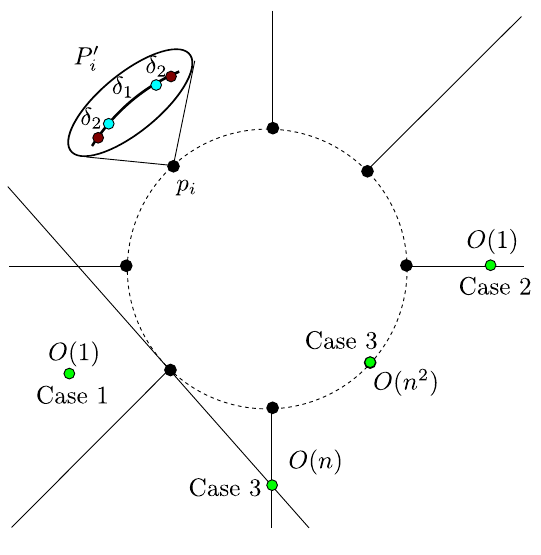
Fig. 4: A bi-colored set with O ( n 2 ) different colored radial